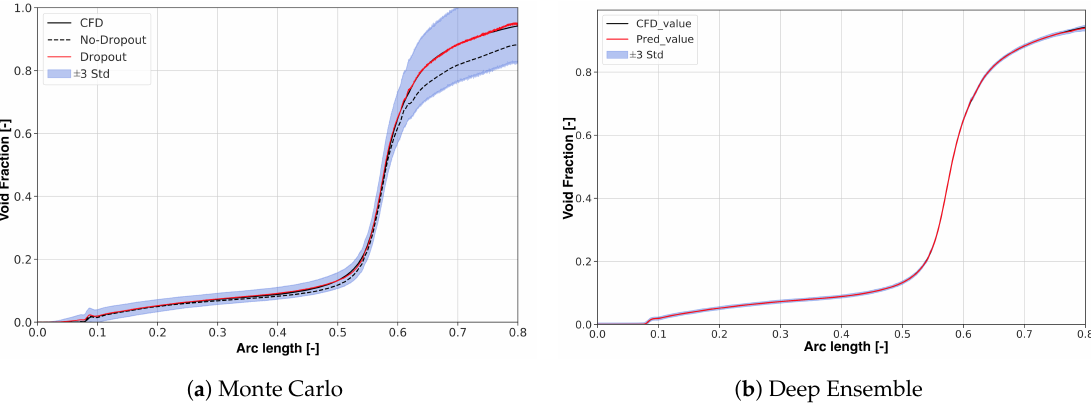
Figure 7. Void Fraction profile along arc length for interpolation dataset using Monte Carlo and Deep Ensemble models at q (cid:48)(cid:48) = 14,000 Wm − 2 and u = 0.05 ms − 1